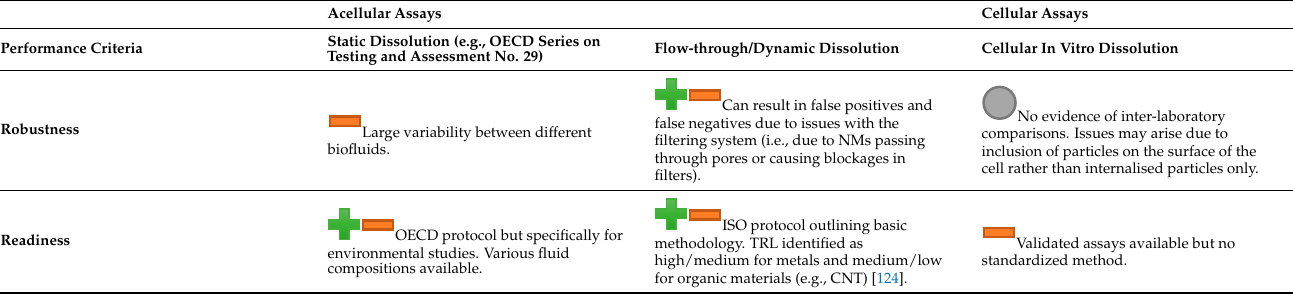
Table 1. Evaluation of suitability of cytotoxicity assays for SbD hazard testing.